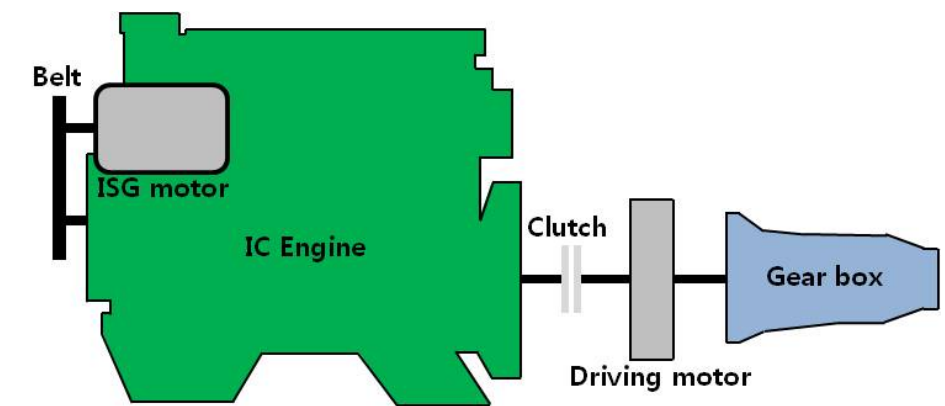
Figure 1. Schematic diagram of the Integrated Starter Generator (ISG) system for HEVs (hybrid electric vehicles)